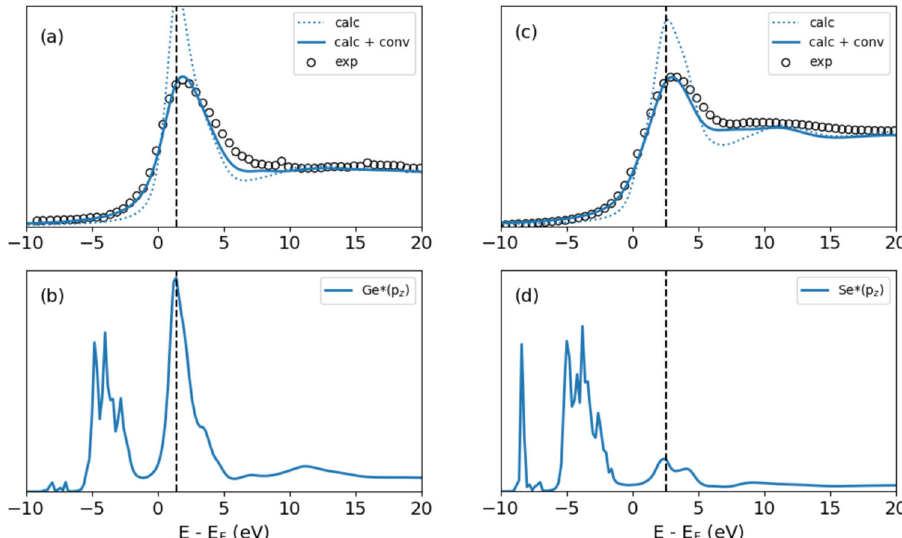
Fig. 3 X-ray absorption: experimental results and theory calculation. a XANES and the calculated x-ray absorption spectra of Ge K . b Calculated density of states with orbital contributions of Ge p z . c XANES and the calculated x-ray absorption spectra of Se K . d Calculated density of states with orbital contributions of Se p z . The open circles in a and c are experimental data, and the lines are the calculated data. In all the plots, we use a relative energy scale with respect to the Fermi energy E F . To ease the comparison with the experimental data (hollow circle line), the calculated XANES spectra (dotted line) were convolved with a Lorentzian pro fi le, resulting in broadened spectra (solid line). The black dashed lines in b and d indicate the positions of maximum p z orbital contributions in the unoccupied states.